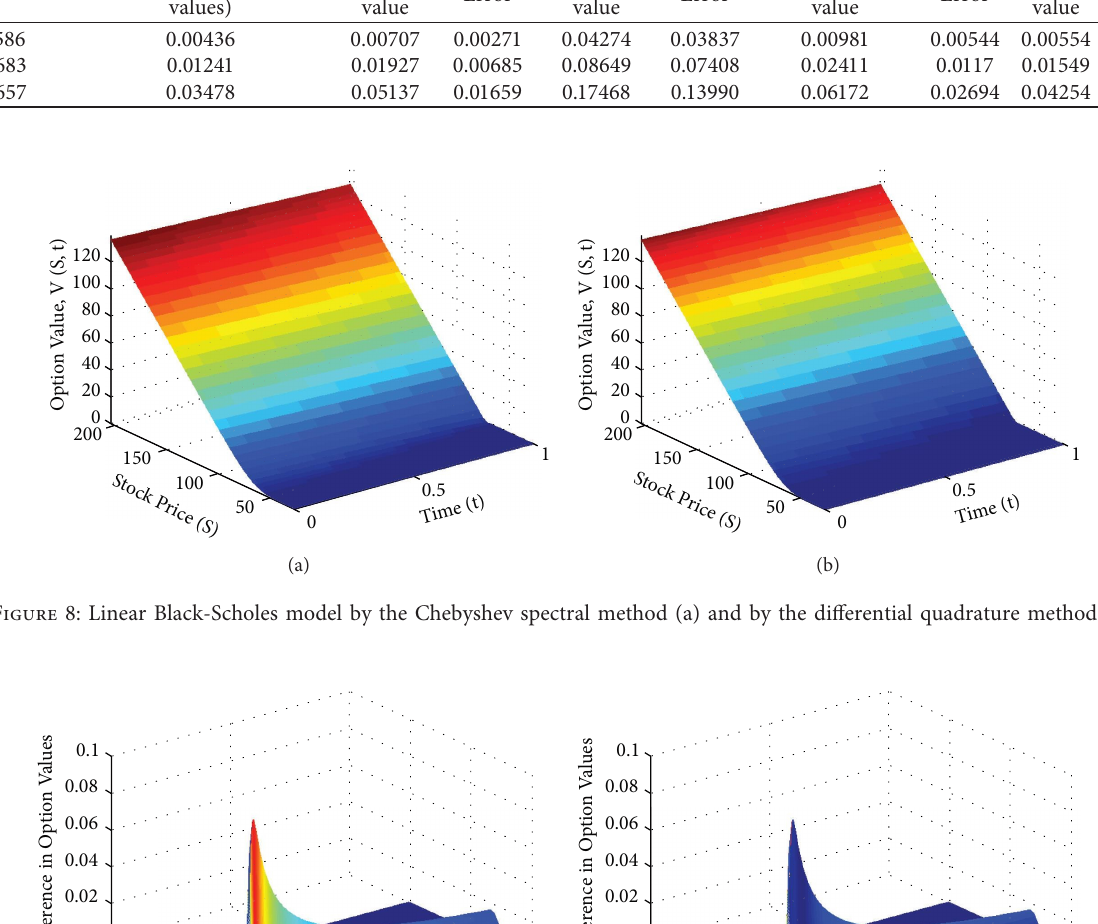
Table 2: The absolute error of volatility models by Chebyshev spectral method at t � 0. Here, BSI means Barles’-Soner’s (identity). Stock price